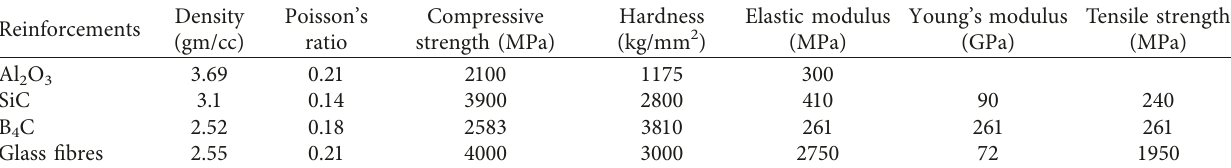
2 O 3 , SiC, B 4 C, and glass fibres.